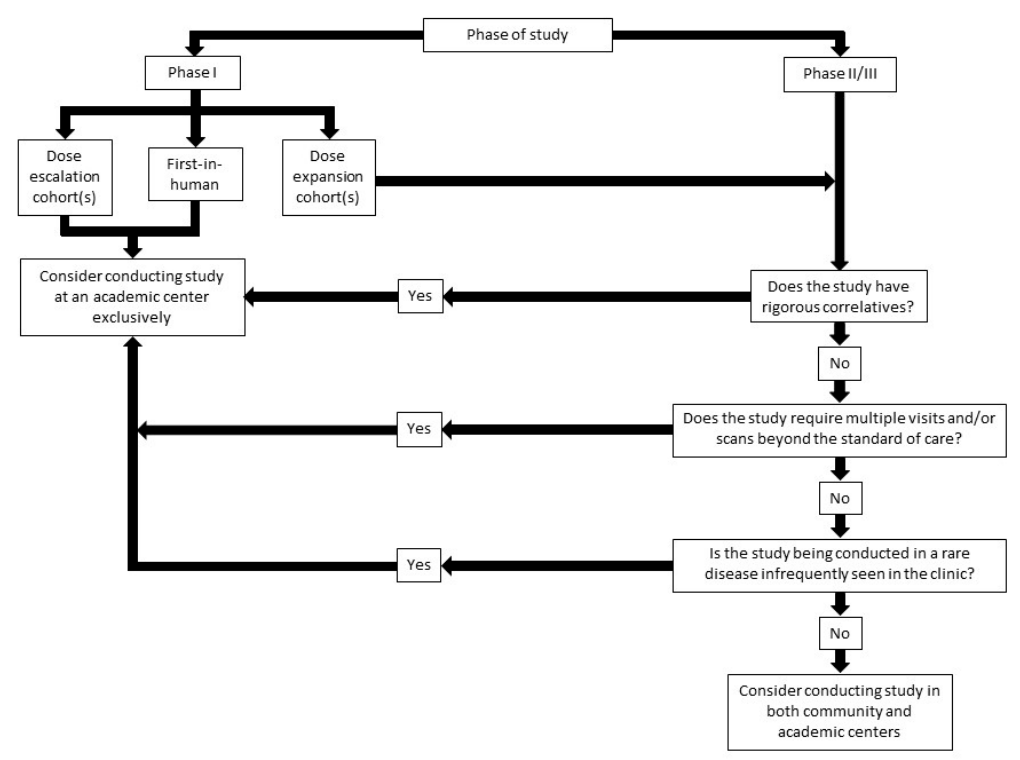
Figure 3. Schema outlining appropriate trial selection for community and academic settings.